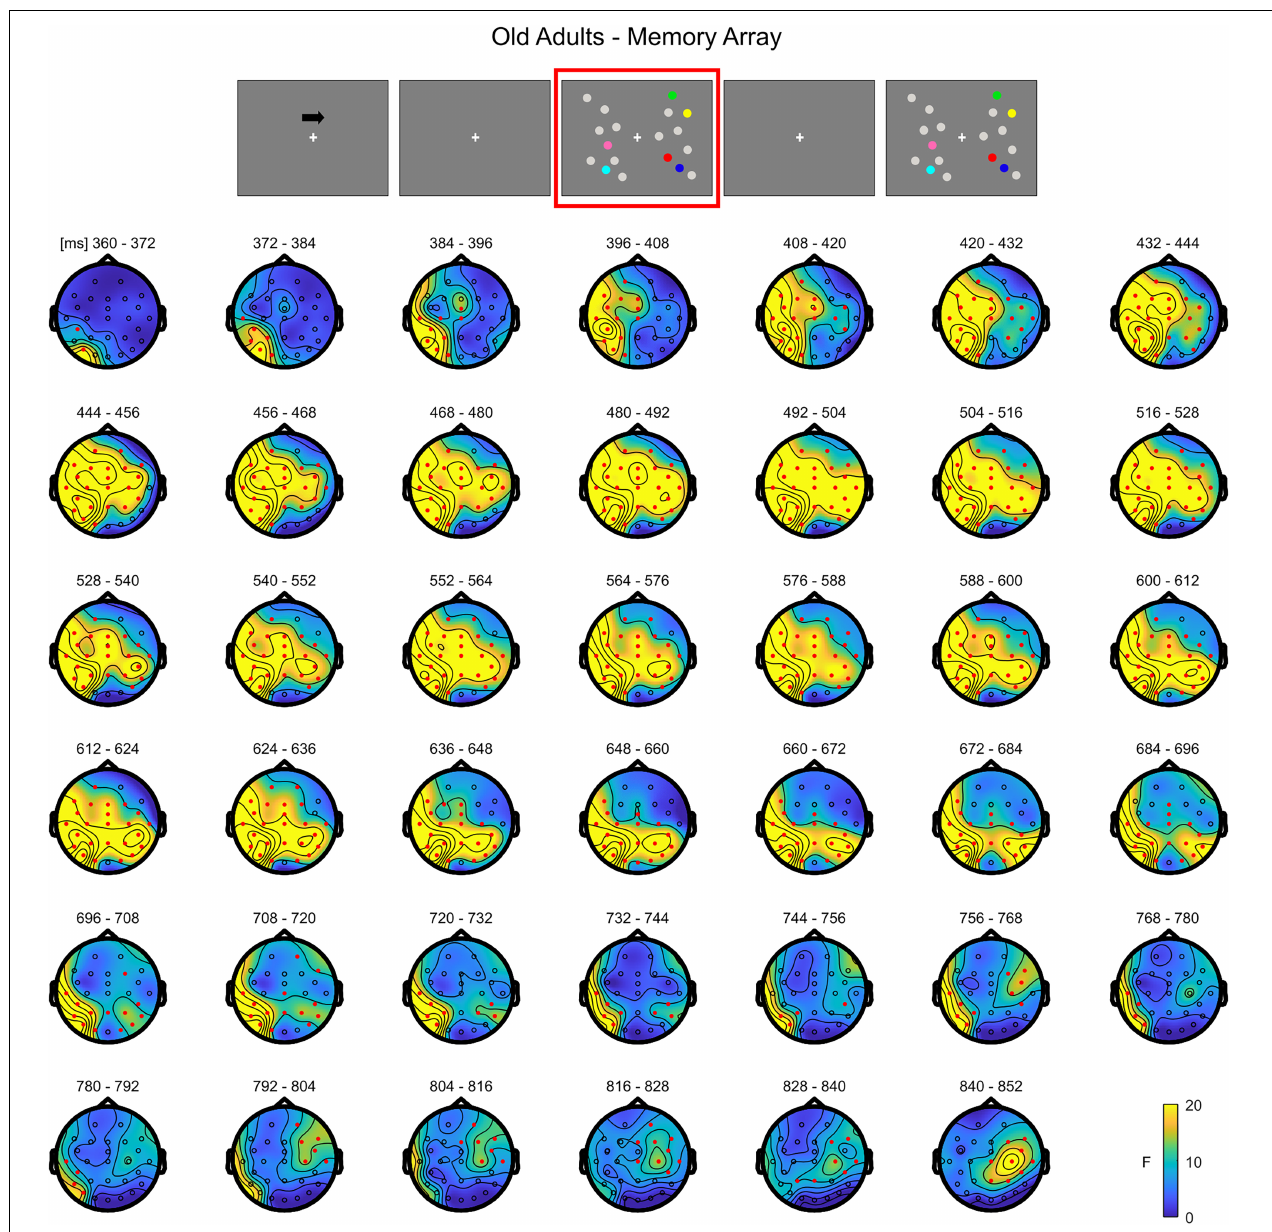
FIGURE 3 | Cluster-based permutation ANOVA results during memory retention in the Older group. The spatio-temporal evolution of the significant Load effect is represented through topographical maps of the clusters averaged in bins of 12 ms. Only significant time windows are depicted (for the complete time course, see Supplementary Figure 2 ). Red dots represent the significant effect. The color bar represents the range of F -values. Left and right channels are set as contralateral and ipsilateral to targets,